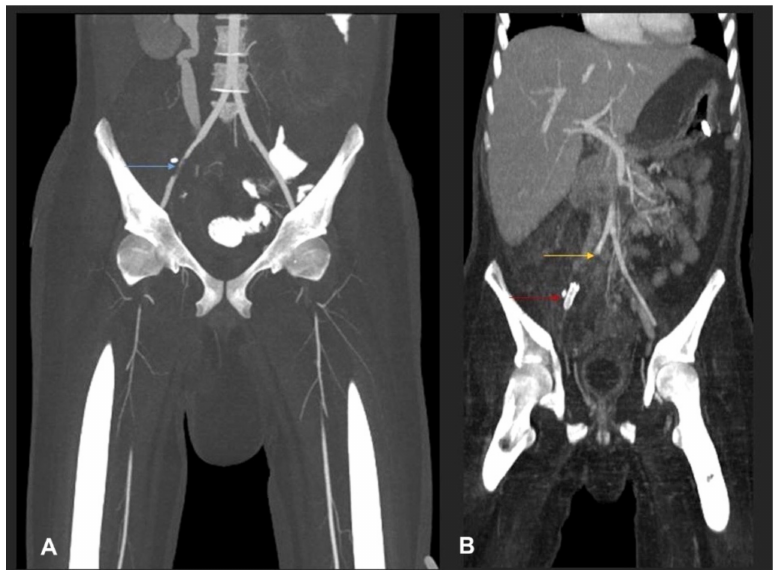
Figure 4. ( A ) MIP coronal CT angiography of aorta and lower limb shows a segmental narrowing and luminal irregularities of right external iliac artery (blue arrow). No occlusion. Distal run off was satisfactory. Rest of the lower limb vessels were patent and normal (not shown). ( B ) MIP coronal image of the aorta and lower limbs shows cut-off of the proximal right common iliac artery suggestive of thrombotic occlusion (yellow arrow). A stent is seen in the right external iliac artery (red arrow). Right iliac fossa shows extensive inflammatory phlegmonous mass-like soft tissue thickening.